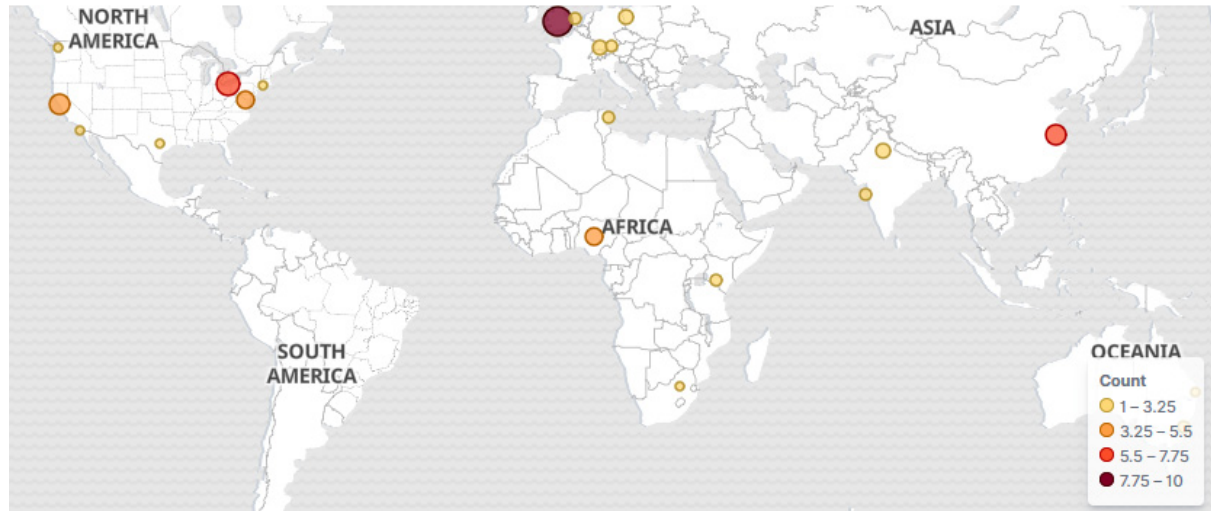
Figure 5. The map of the world with the origins of posts on PV inverters. To verify the results, a test was carried out by using Google Trends, which showed the average number of hits for worldwide searches as follows: Fronius with 77, Growatt—49, and Solaredge with 47 hits, for one year back from September 2020, shown in weekly averages. Figure 6 shows the results of global and Hungarian average searches in a week. This differs from the social media research greatly, since here only conclusions about popularity can be